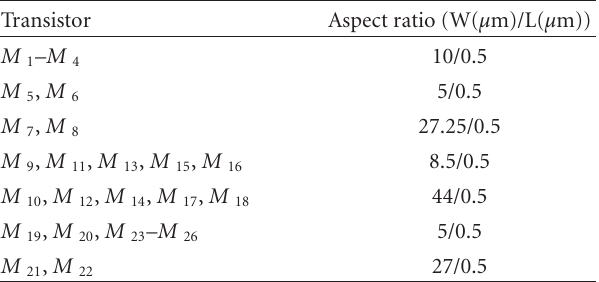
Table 1: Aspect ratio of various transistors.